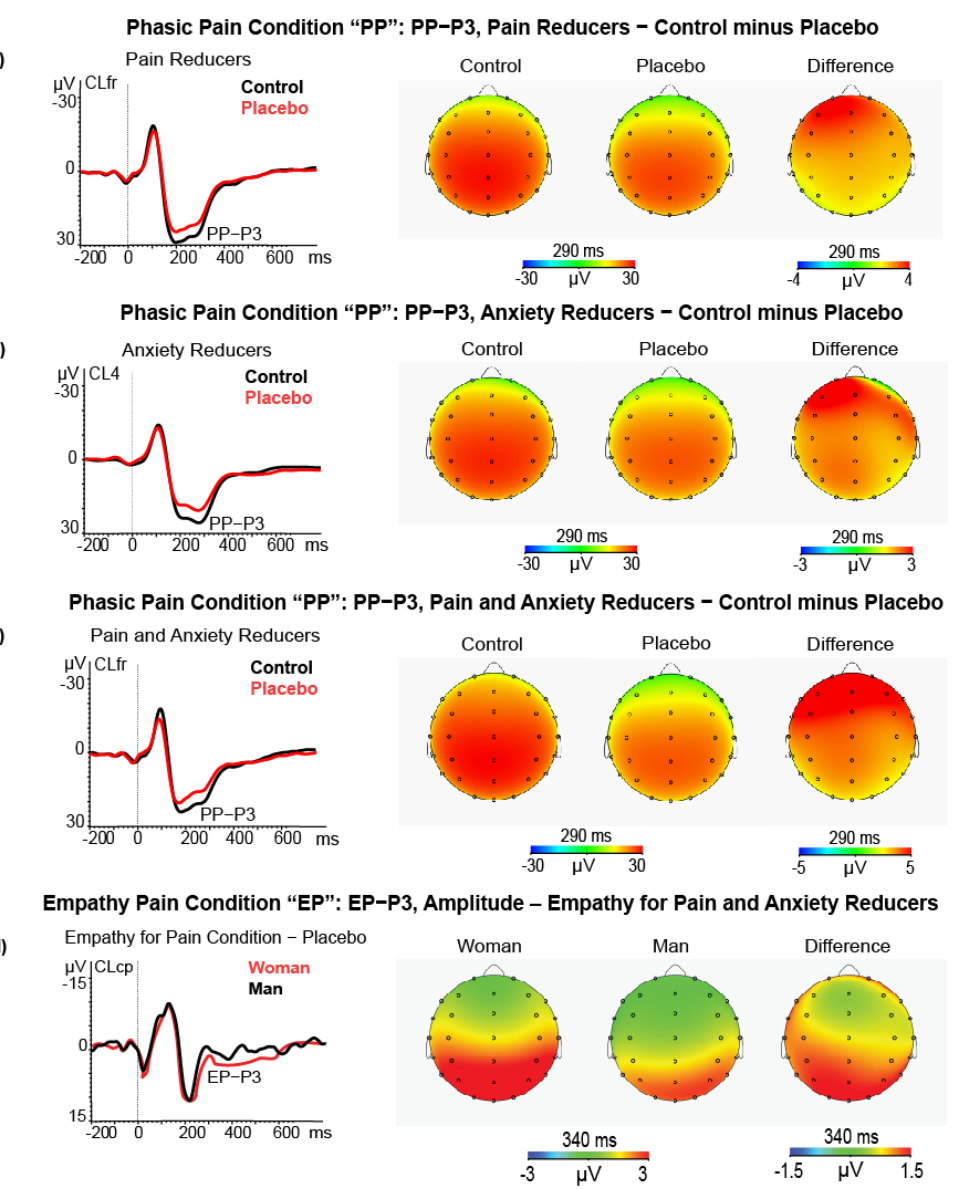
Figure 7. ( a ) ERP, Scalp maps and difference (control minus placebo) maps of PP − P3 amplitude in high pain reducers ( N = 32); ( b ) ERP, Scalp maps, and difference maps of PP − P3 amplitude for control and placebo treatments in high state anxiety reducers ( N = 26); ( c ) ERP, Scalp maps and difference maps of PP − P3 amplitude in high pain and state anxiety reducers ( N = 15); ( d ) ERP, Scalp maps and difference maps of EP − P3 amplitude in women ( N = 32) vs. men ( N = 31) during the empathy pain condition.